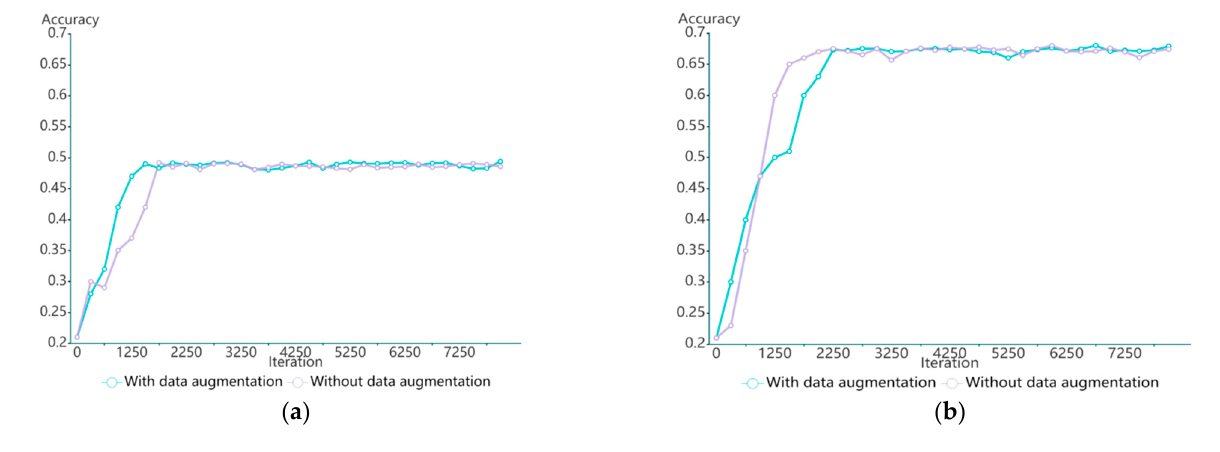
Table 4. Classification accuracies (%) with different methods in the 5-way K-shot cases on